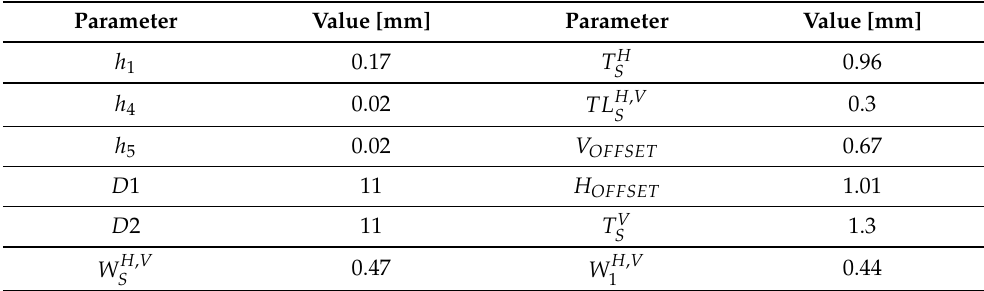
Table 1. The fixed design parameters.